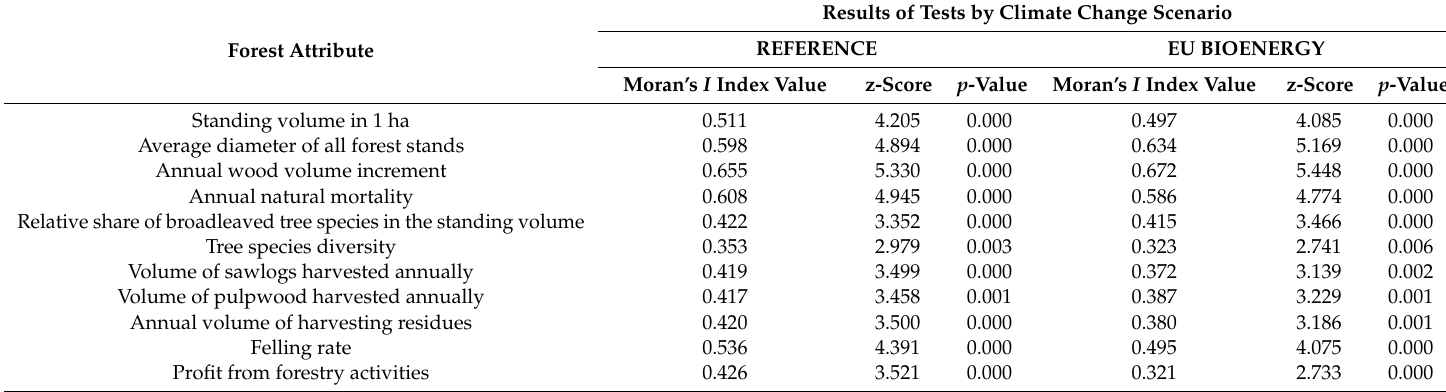
Table A4. Results of tests for the presence of global spatial autocorrelation of the